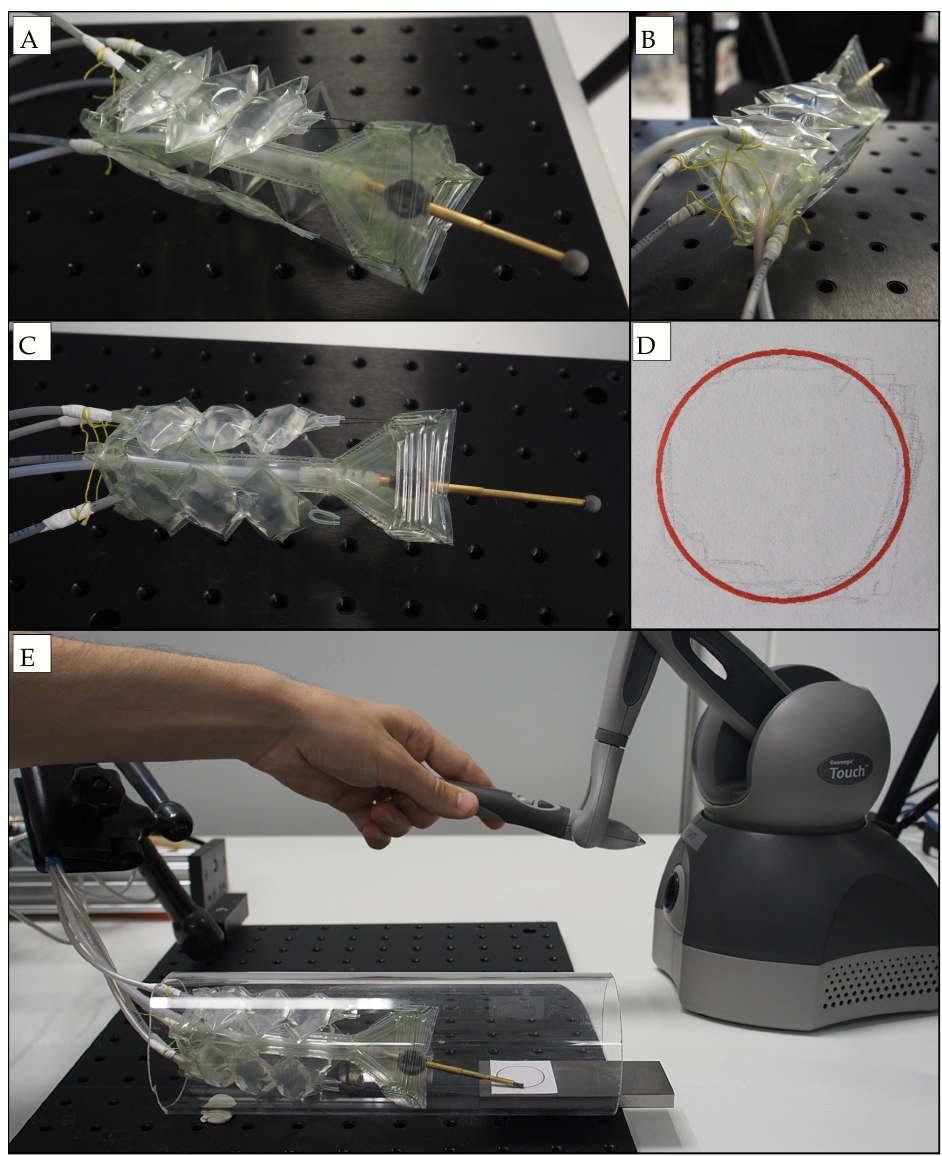
Figure 10. Deployable robot, test setup, and result. ( A – C ) Deployable robot at different angles. ( D ) Result of path tracing task for a 30 mm diameter circle. ( E ) Test setup image taken during